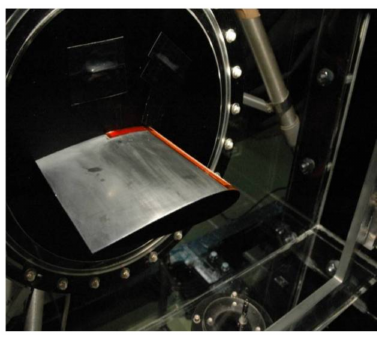
Figure 4. Airfoil model with the DBD plasma actuator in the wind